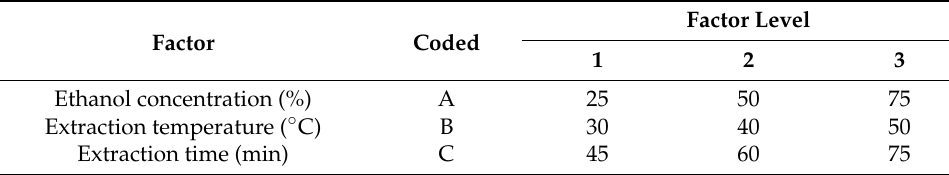
Table 1. Taguchi method factors and level selection for analyzing the antioxidant ability of each part of Chenopodium formosanum . Factor Level Factor Coded 1 2 3 Ethanol concentration (%) A 25 50 75 Extraction temperature ( ◦ C) B 30 40 50 Extraction time (min) C 45 60 75